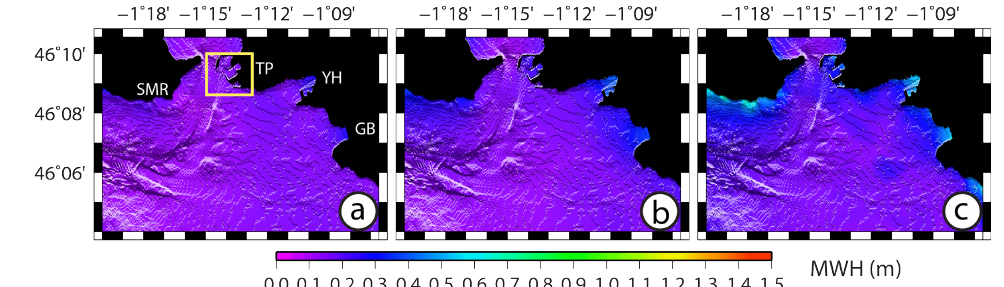
Figure 10. Maximum wave height maps obtained after 12h of propagation showing coastal amplifications in the passage of Antioche (grid 8) for the 3 scenarios. From left to right, scenarios 1 (a) , 2 (b) and 3 (c) . The yellow rectangle shows the position of the following grid 9. SMR: Sainte-Marie-de-Ré, TP: trade port, YH: yacht harbor, GB: Godechaud Bay.